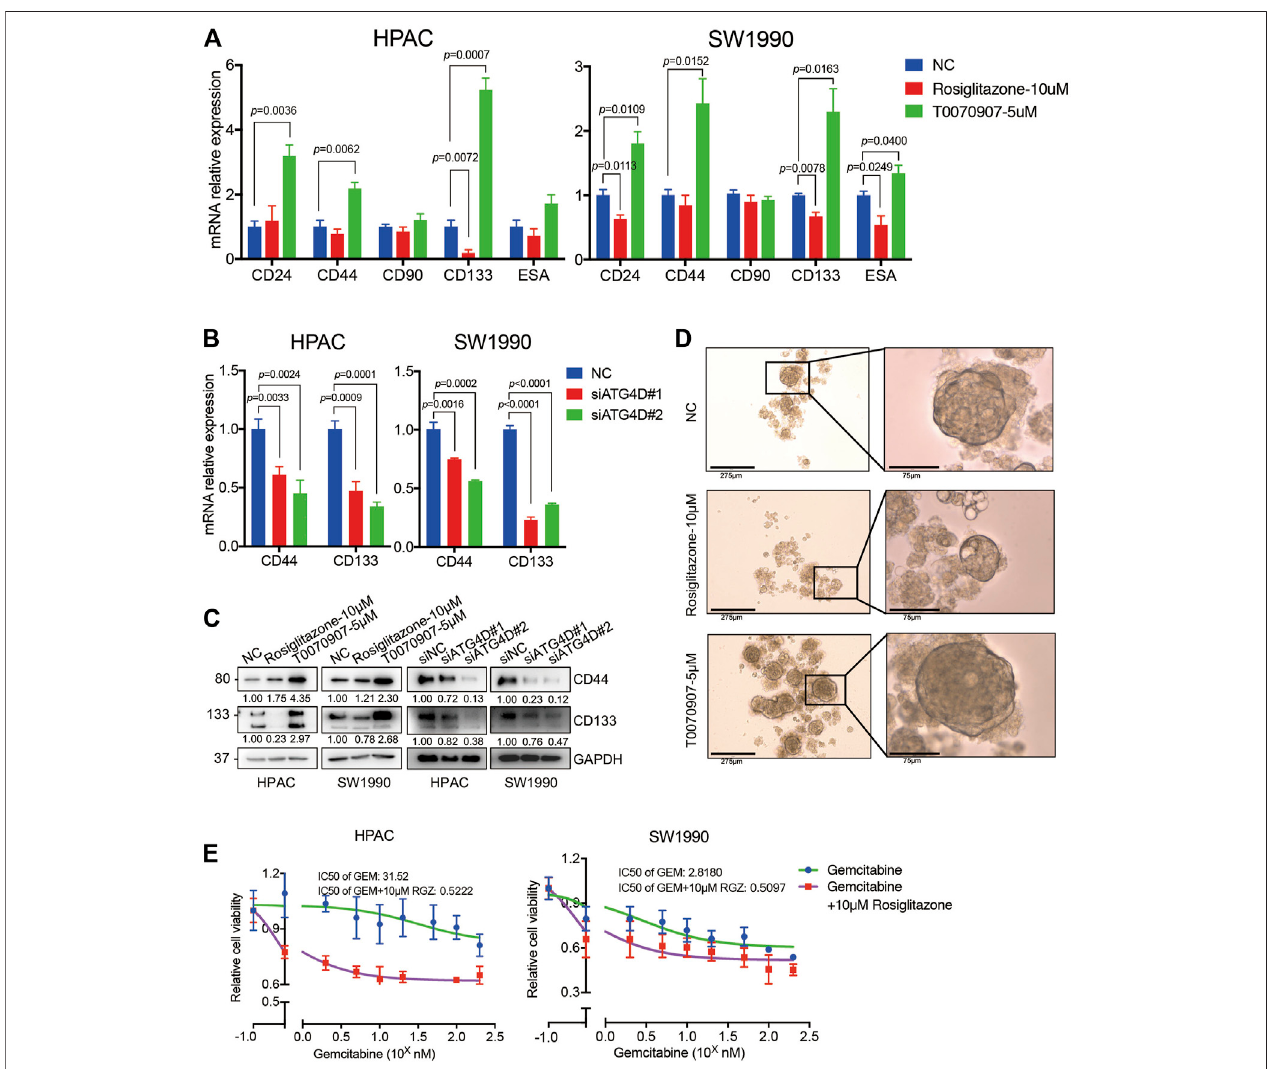
FIGURE 7 | PPAR γ inhibits the capacity of pancreatic cancer cell stemness and induces the sensitivity of Gemcitabine treatment. (A) Treating HPAC or SW1990 cells with negative control, Rosiglitazone (10 μ M) or T0070907 (5 μ M) for 72 h affected the CD44 and CD133 mRNA expression levels. (B) Knockdown of ATG4D by siRNA in HPAC and SW1990 cells decreased the CD44 and CD133 mRNA expression levels. (C) PPAR γ activation or inhibition, or ATG4D downregulation affected CD44andCD133proteinexpressionlevels. (D) Rosiglitazonecouldpromote,whileT0070907couldinhibitthesphere-formationcapacityofHPACcellscompared to negative control groups. (E) Combination of Rosiglitazone and Gemcitabine in HPAC and SW1990 cells signi fi cantly inhibited tumor cell viability compared with Gemcitabine alone. Experiments were repeated at least three times, with statistical analyses being reported appropriate.